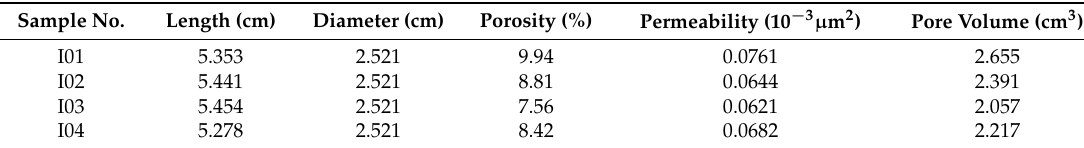
Table 1. Petrophysical properties of core samples.